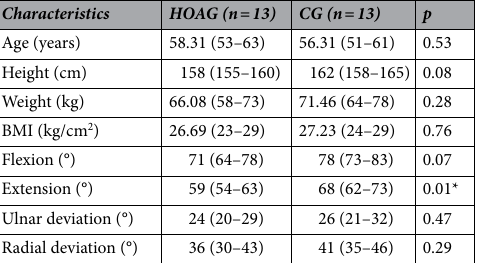
Table 1. Characteristics and values of the wrist range of motion in both groups. *Significant difference.